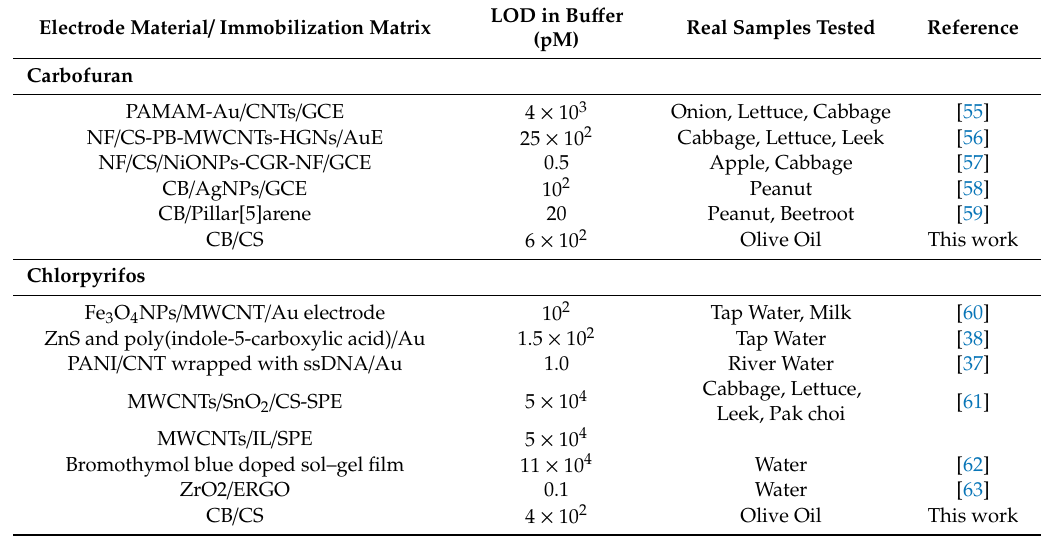
Table 2. AChE-based biosensors for determination of carbamate and organophosphorus pesticides. Electrode Material / Immobilization Matrix